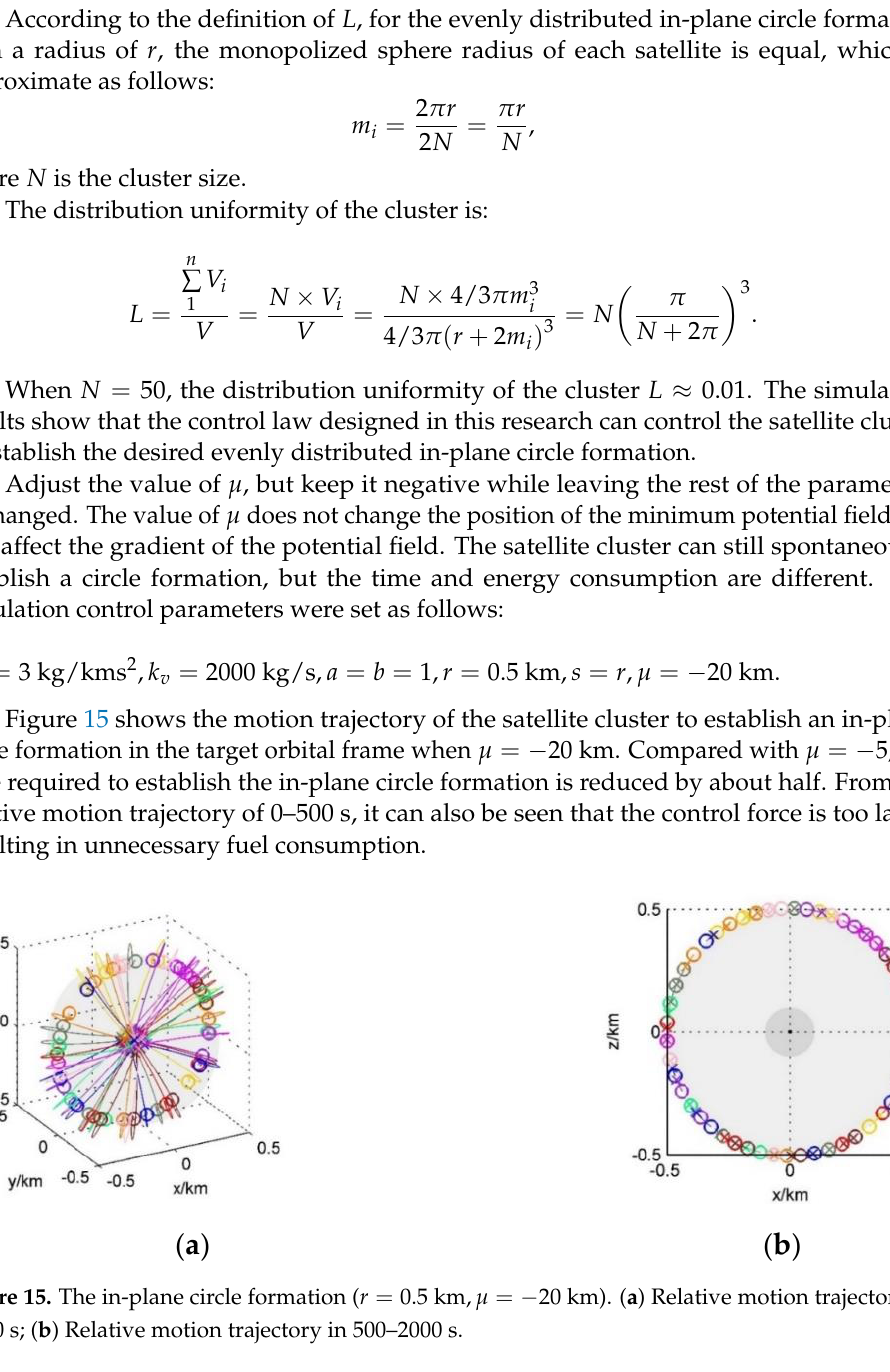
( b ) Figure 16. The in-plane circle formation (